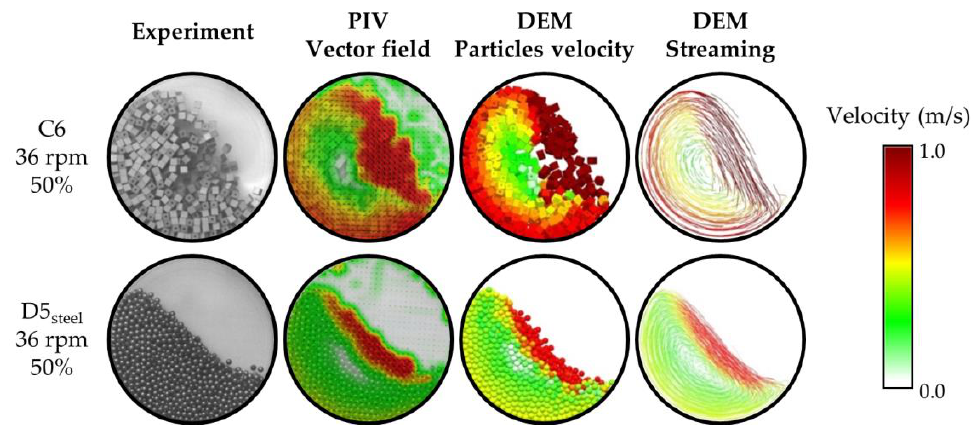
Figure 5. Validation of virtual material movement via particle image velocimetry (PIV) analysis and discrete element method (DEM) visualization.